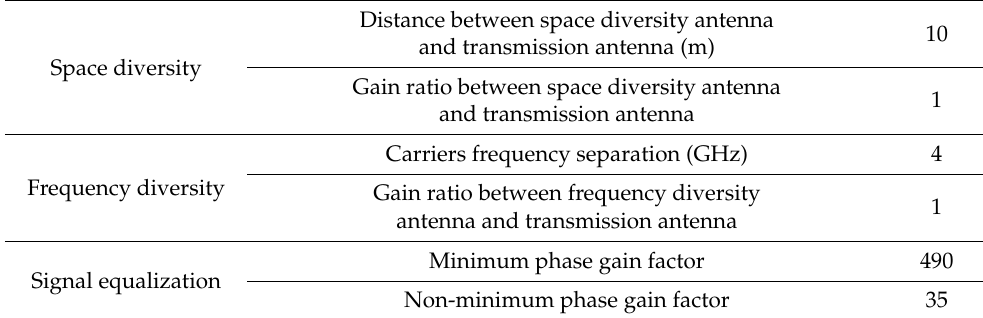
Table 7. Diversity and equalization characteristics for the simulated terrestrial project.